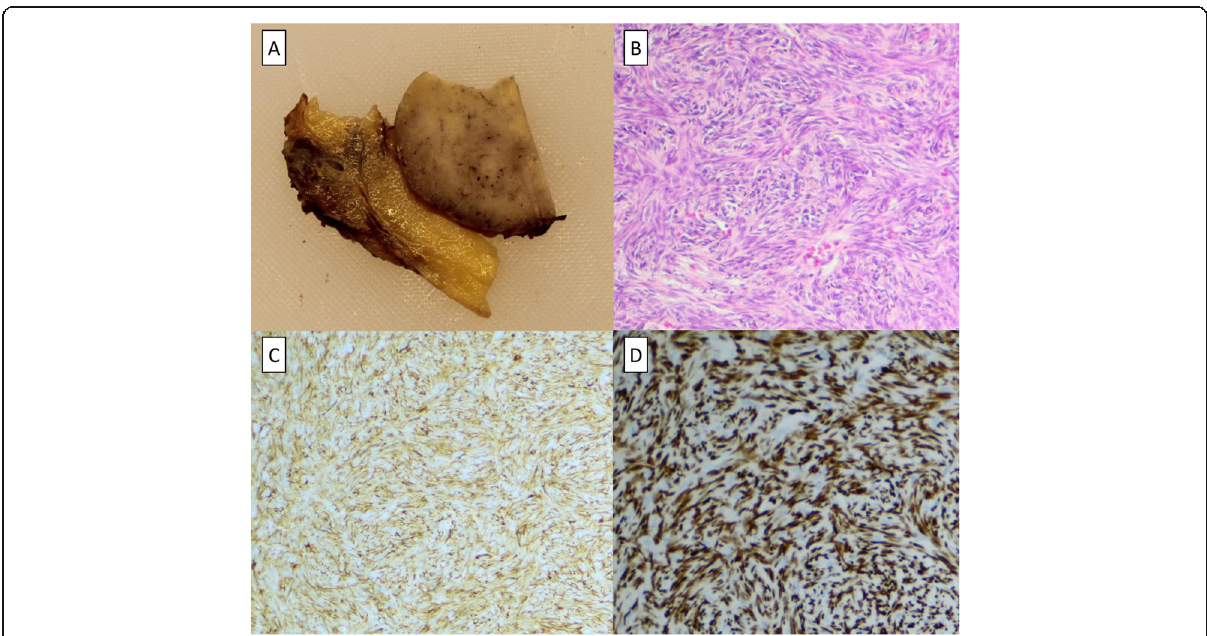
Fig. 2 Immunohistochemistry stainings of the resected lesion. a Resected right adrenal mass of 10 × 7.5 × 3.5 cm. b HE staining, showing fascicles of spindled to ovoid-shaped cells and a hemangiopericytoma-like vessel pattern, original magnification × 100. c Diffuse positive CD-34 immunostaining, original magnification × 100. d Diffuse positive STAT6 immunostaining, original magnification ×